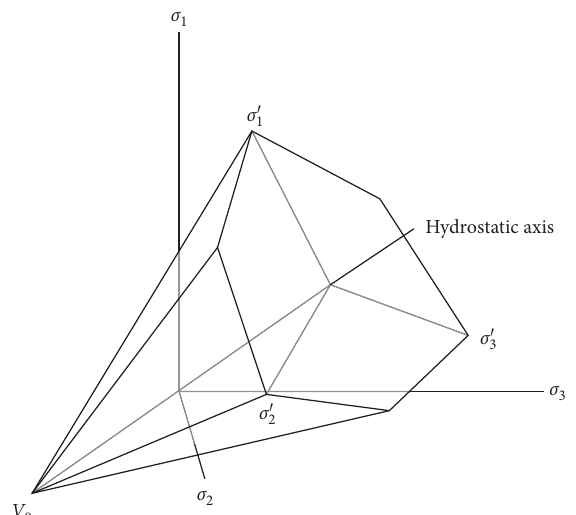
Figure 1: Six-sided pyramidal failure surface of the PMC